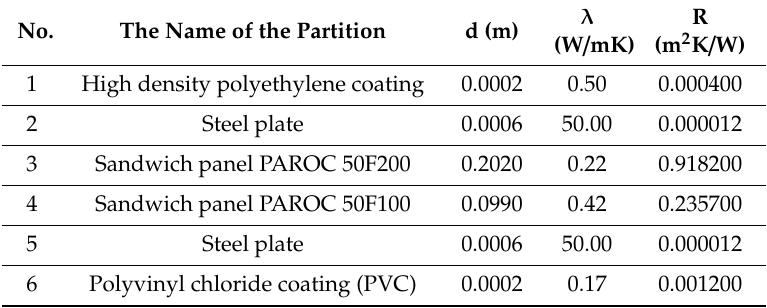
Table 2. Parameter values for subsequent partitions in the external wall of the building [67]. No. The Name of the Partition